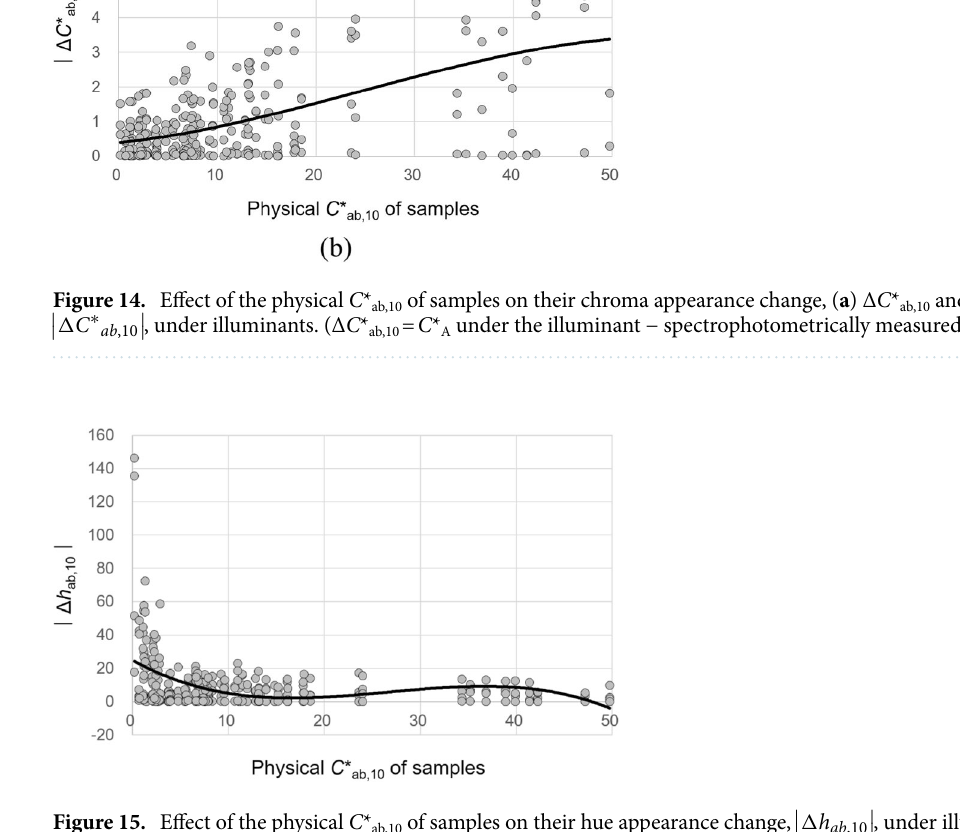
Figure 15. Effect of the physical C * ab,10 of samples on their hue appearance change, (Δ h ab,10 = h A under the illuminant − spectrophotometrically measured h ab,10